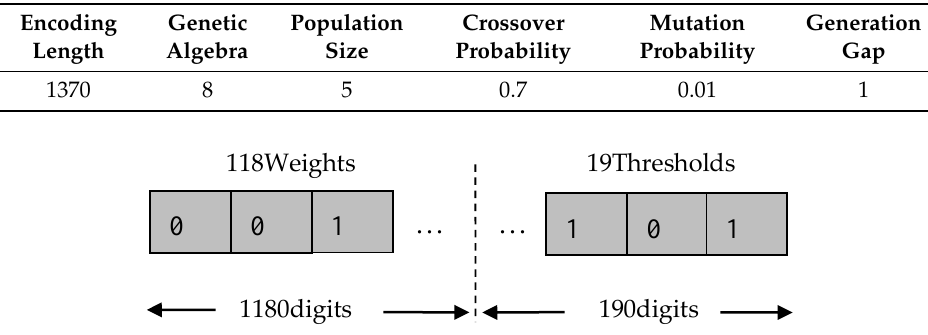
Figure 10. The binary coding of the neural network initial weights and thresholds.